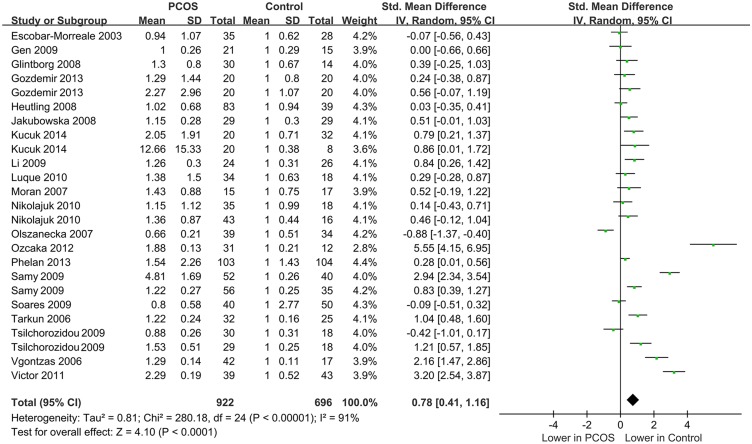
The pooled quantitative synthesis for IL-6 levels in PCOS patients compared with controls.